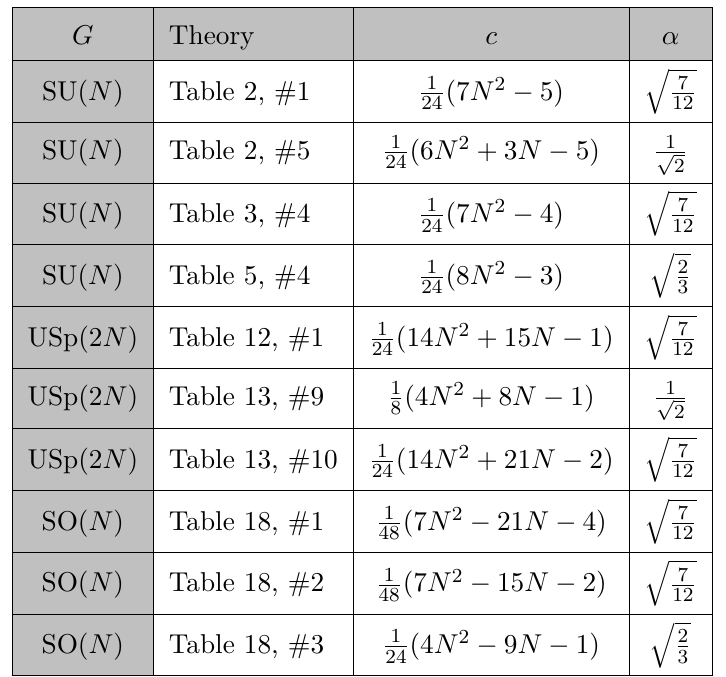
Table 2. Computation of α for d = 4 , N = 1 SCFTs with simple gauge group, to leading order in large N . We list all entries of the classification of [115] that admit large N limits, referring to the table entry in